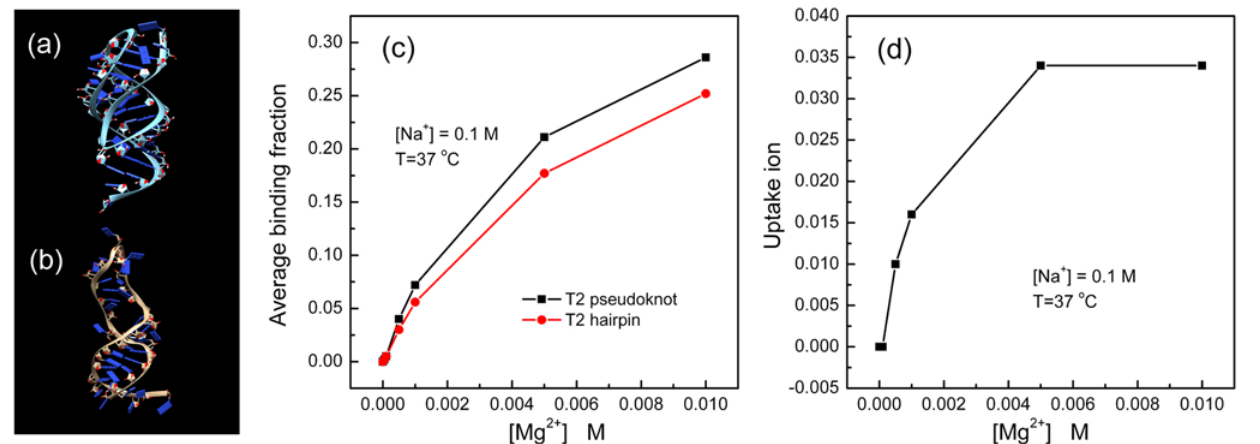
Fig 7. The binding fraction and the uptake of Mg 2+ ions as a function of [Mg 2+ ]. (a) and (b) show the 3D structures of the T2 pseudoknot (the folded state) and T2 hairpin (the intermediate state), respectively; (c) shows the binding fraction curves for the T2 pseudoknot (black) and the hairpin (red). (d) shows the Mg 2+ uptake as a function of [Mg 2+